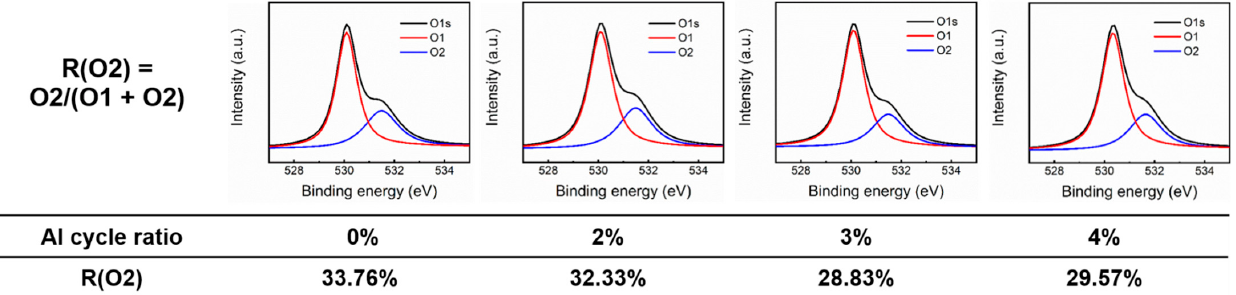
Figure 7. XPS spectra of ZnO and AZO films. Al cycle ratio and R(O2) are list below XPS spectra. ZnO and AZO films were deposited on silicon substrates.